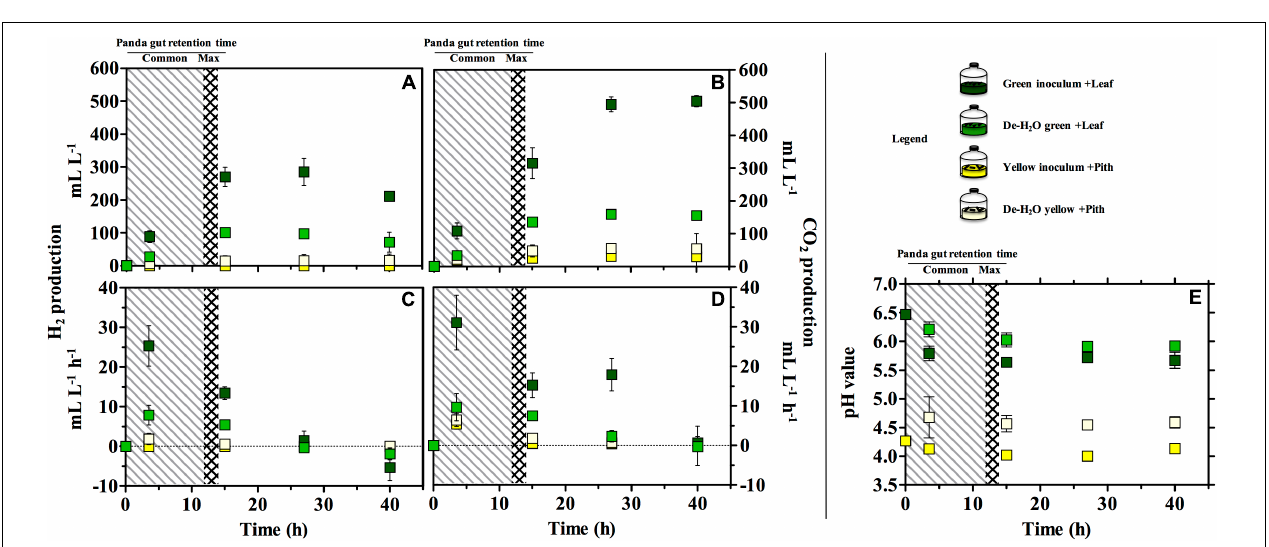
FIGURE 3 | H 2 (A,C) , CO 2 production (B,D) and pH (E) in laboratory-scale fermentation tests ( n = 3) using microbiomes derived from giant panda fecal samples ( Figure 2 ). Common [generally up to 12 h (Dierenfeld et al., 1982; Mainka et al., 1989; Edwards et al., 2006; Senshu et al., 2007)] and maximum [14 h (Schaller et al., 1985)] gut retention times observed in giant pandas are indicated with shaded areas. Keys reported in the graph.